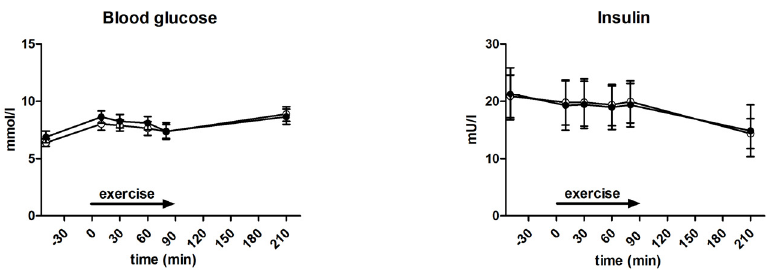
Figure 2. Measured blood glucose and insulin during GLUFRU (black circle) and GLU (white circle). Left to right: blood glucose, p = 0.67; insulin, p = 0.89. Results are expressed as mean ± SEM.